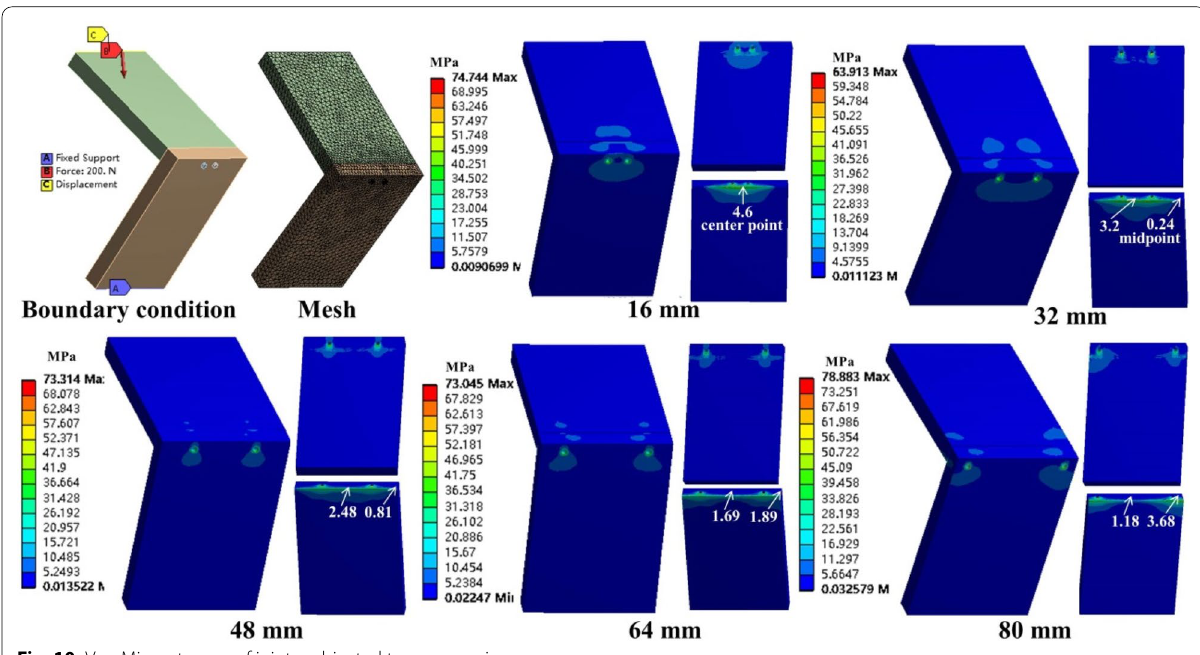
Fig. 10 Von Mises stresses of joints subjected to